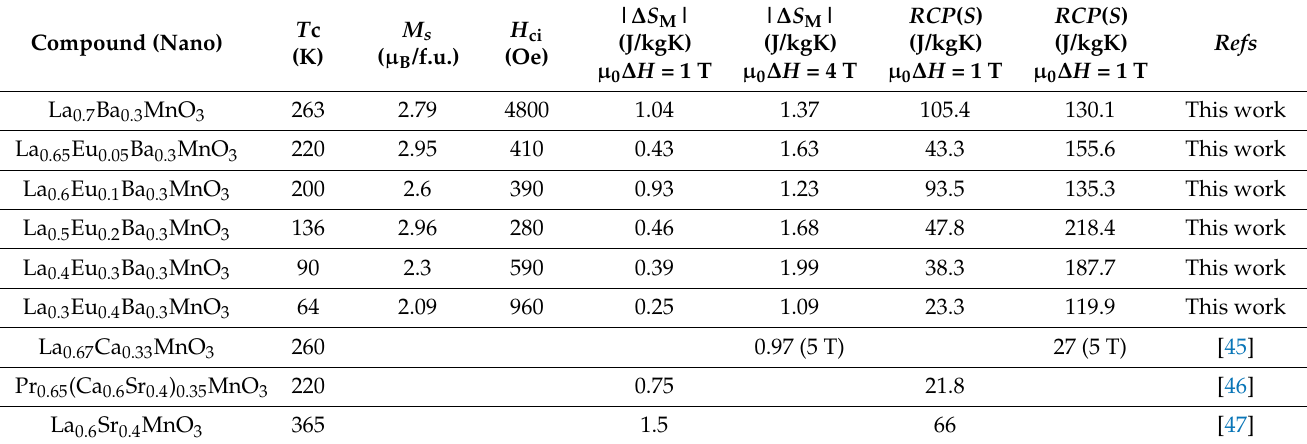
Table 7. Experimental values for La 0.7 − x Eu x Ba 0.3 MnO 3 nano